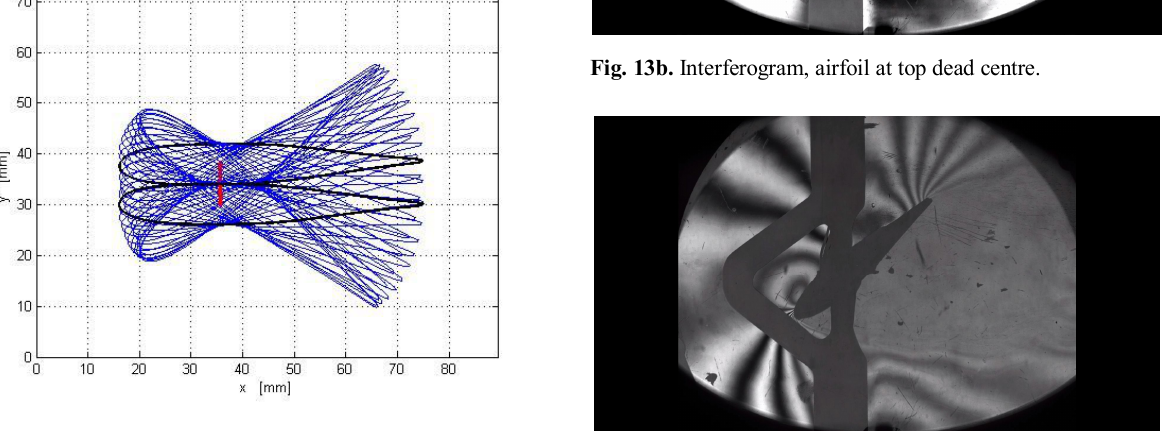
Fig. 12. The kinematics of the airfoil corresponding to the interferograms 2663-05, M=0,45.